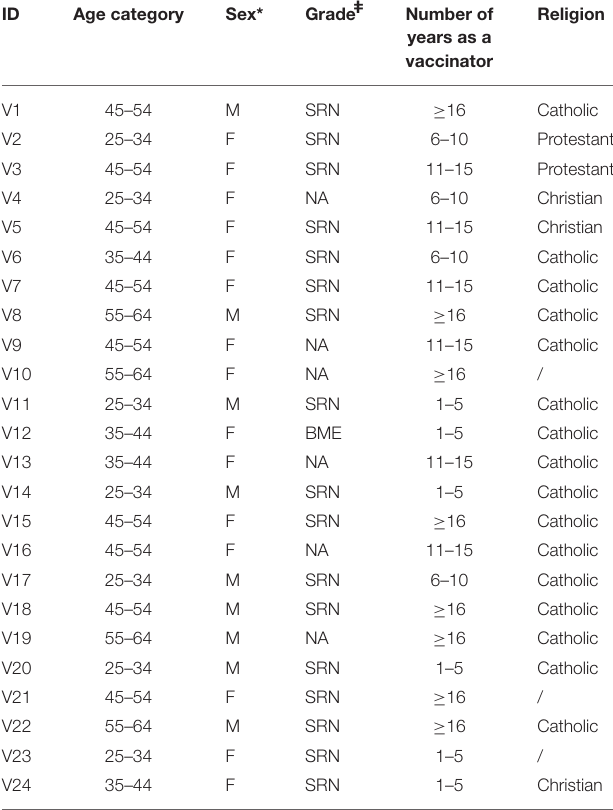
TABLE 1 | Socio demographic characteristics of